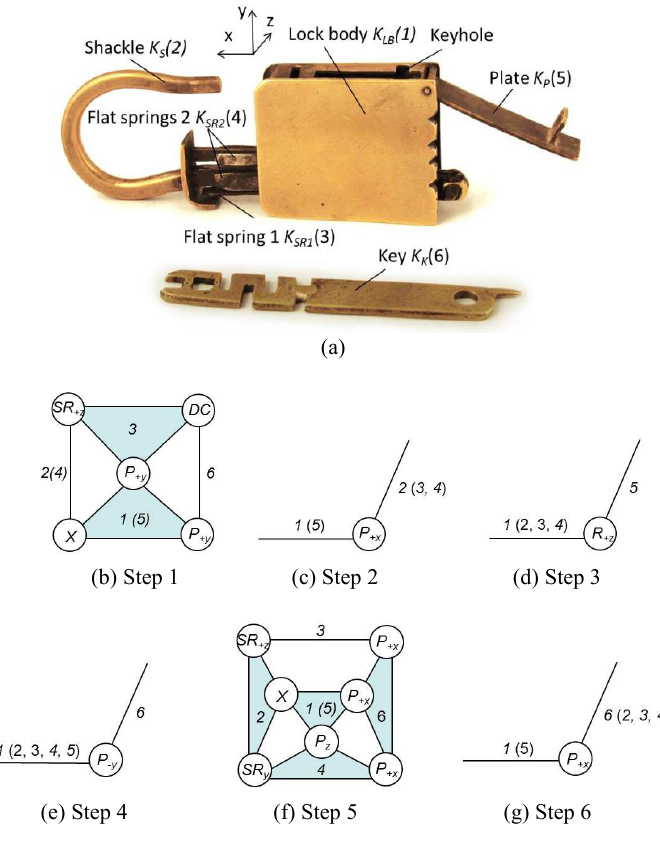
Figure 7. Padlock with a poke